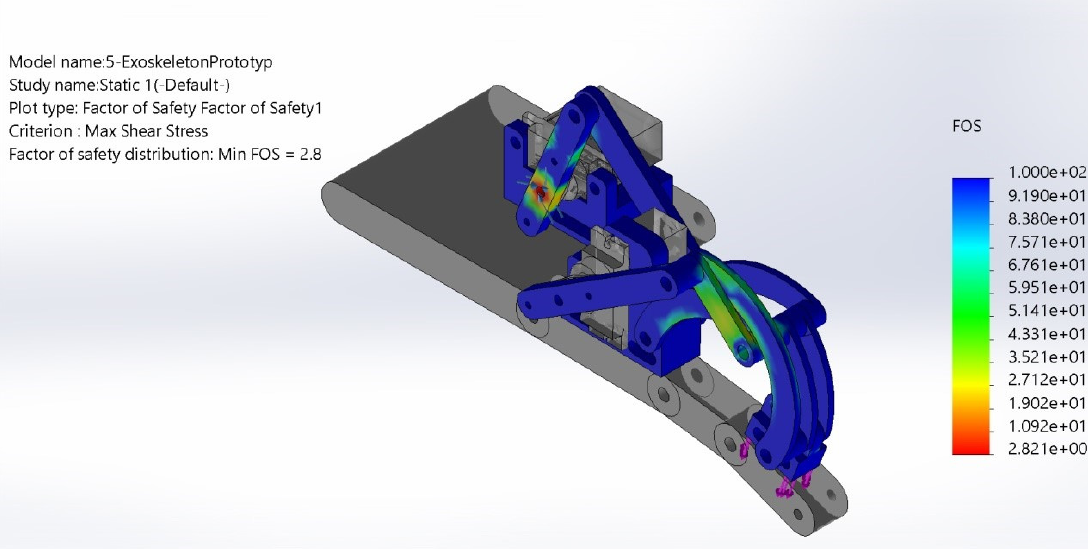
Figure 17. FEM factor of safety calculations based on maximum shear stress.